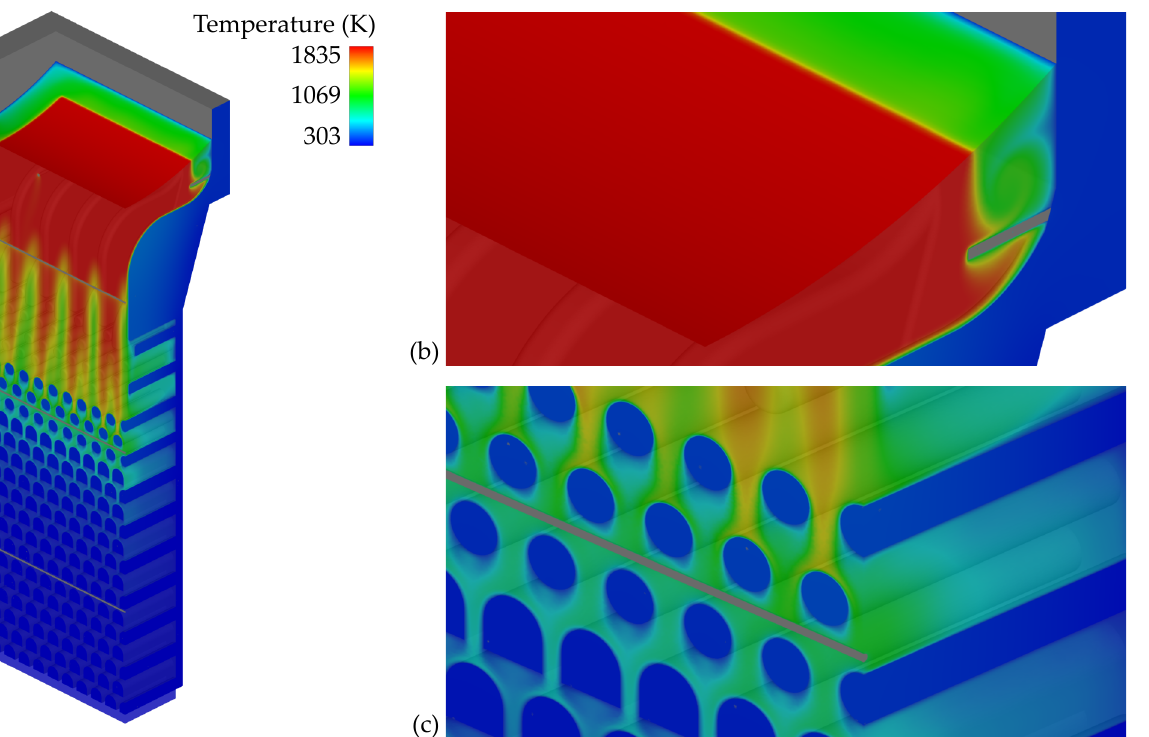
Figure 7. Results of the simulation for the highest operating point. ( a ) Overview of the model; ( b ) Detail view of the thermocouple TC-171; ( c ) Detail view of the thermocouple TC-152.